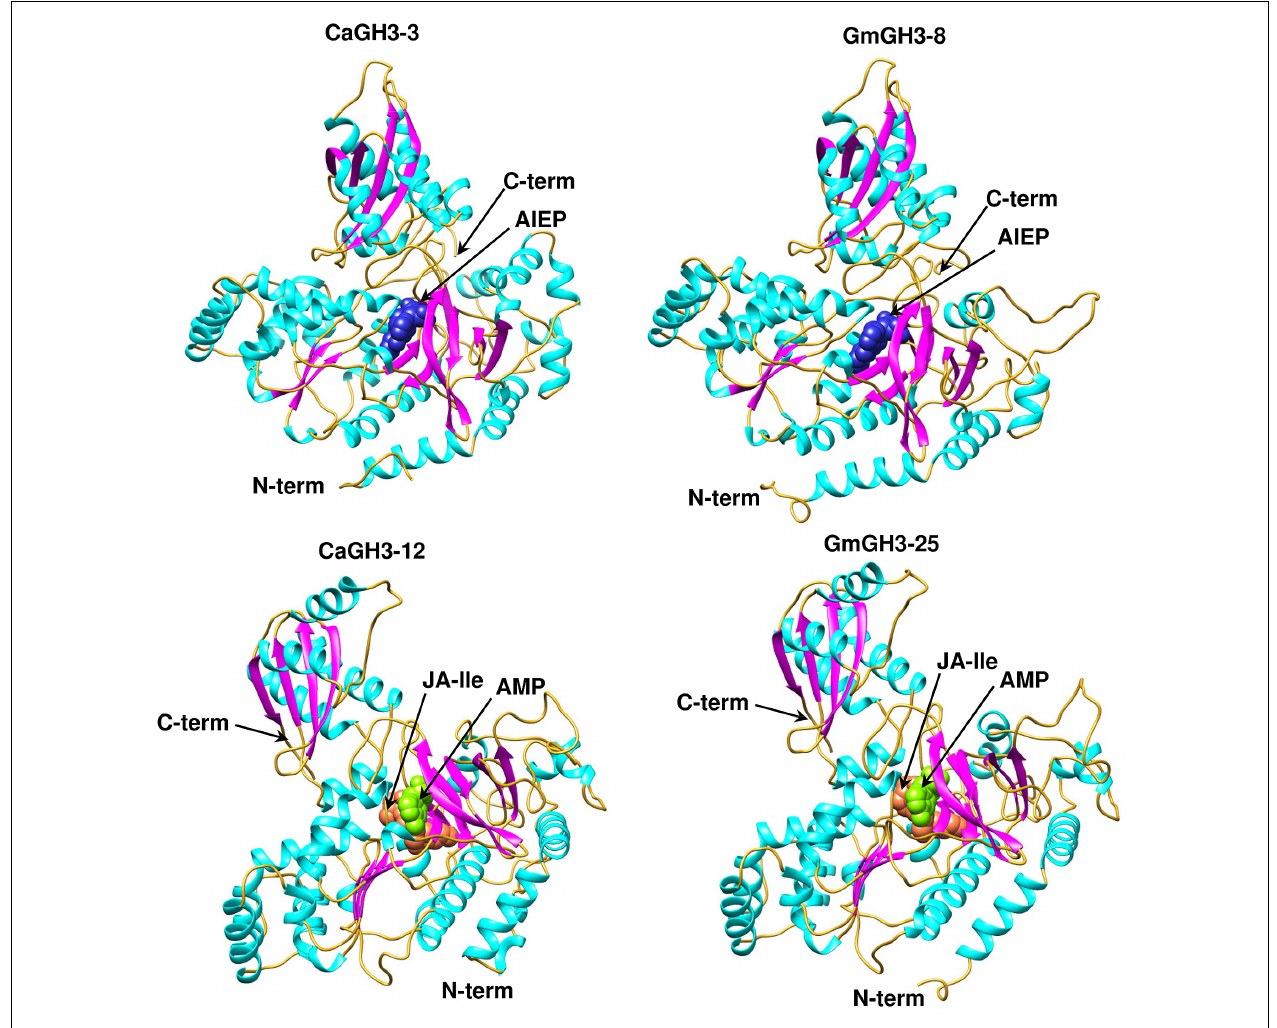
FIGURE 6 | Predicted structures of GH3 proteins. Ribbon diagram showing the N - and C -terminal domains of chickpea (CaGH3-3 and CaGH3-8) and soybean (GmGH3-8 and GmGH3-25) GH3 protein with α -helices, β -strands